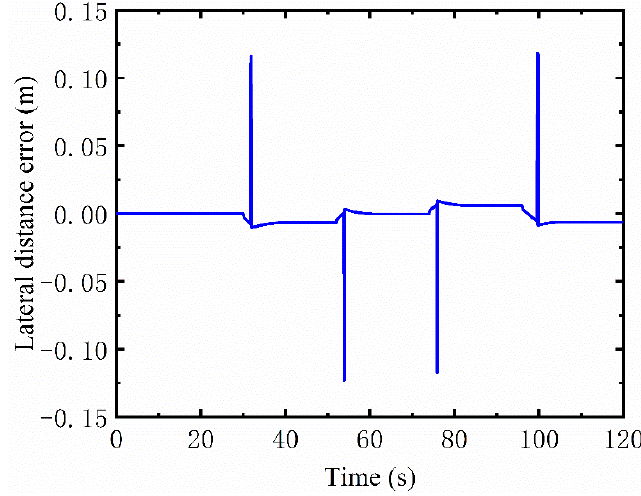
ation of vehicles based on lateral positioning algorithm; ( b ) Local enlargement.